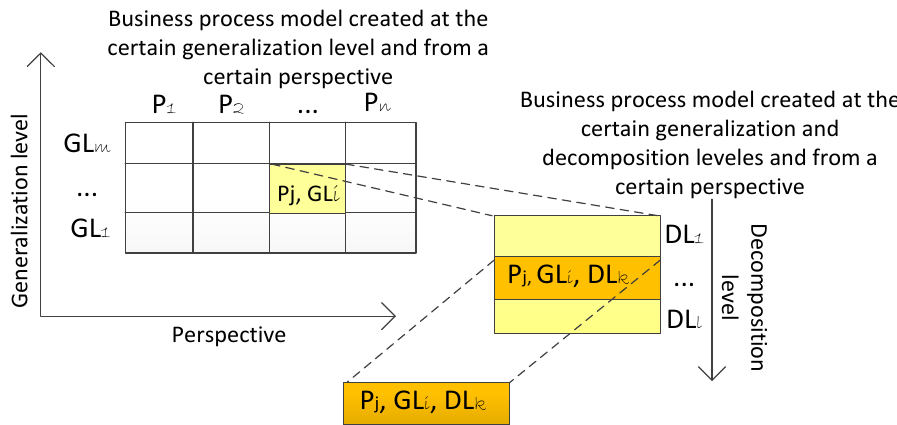
Figure 6. Interdependence between business process modeling goal’s